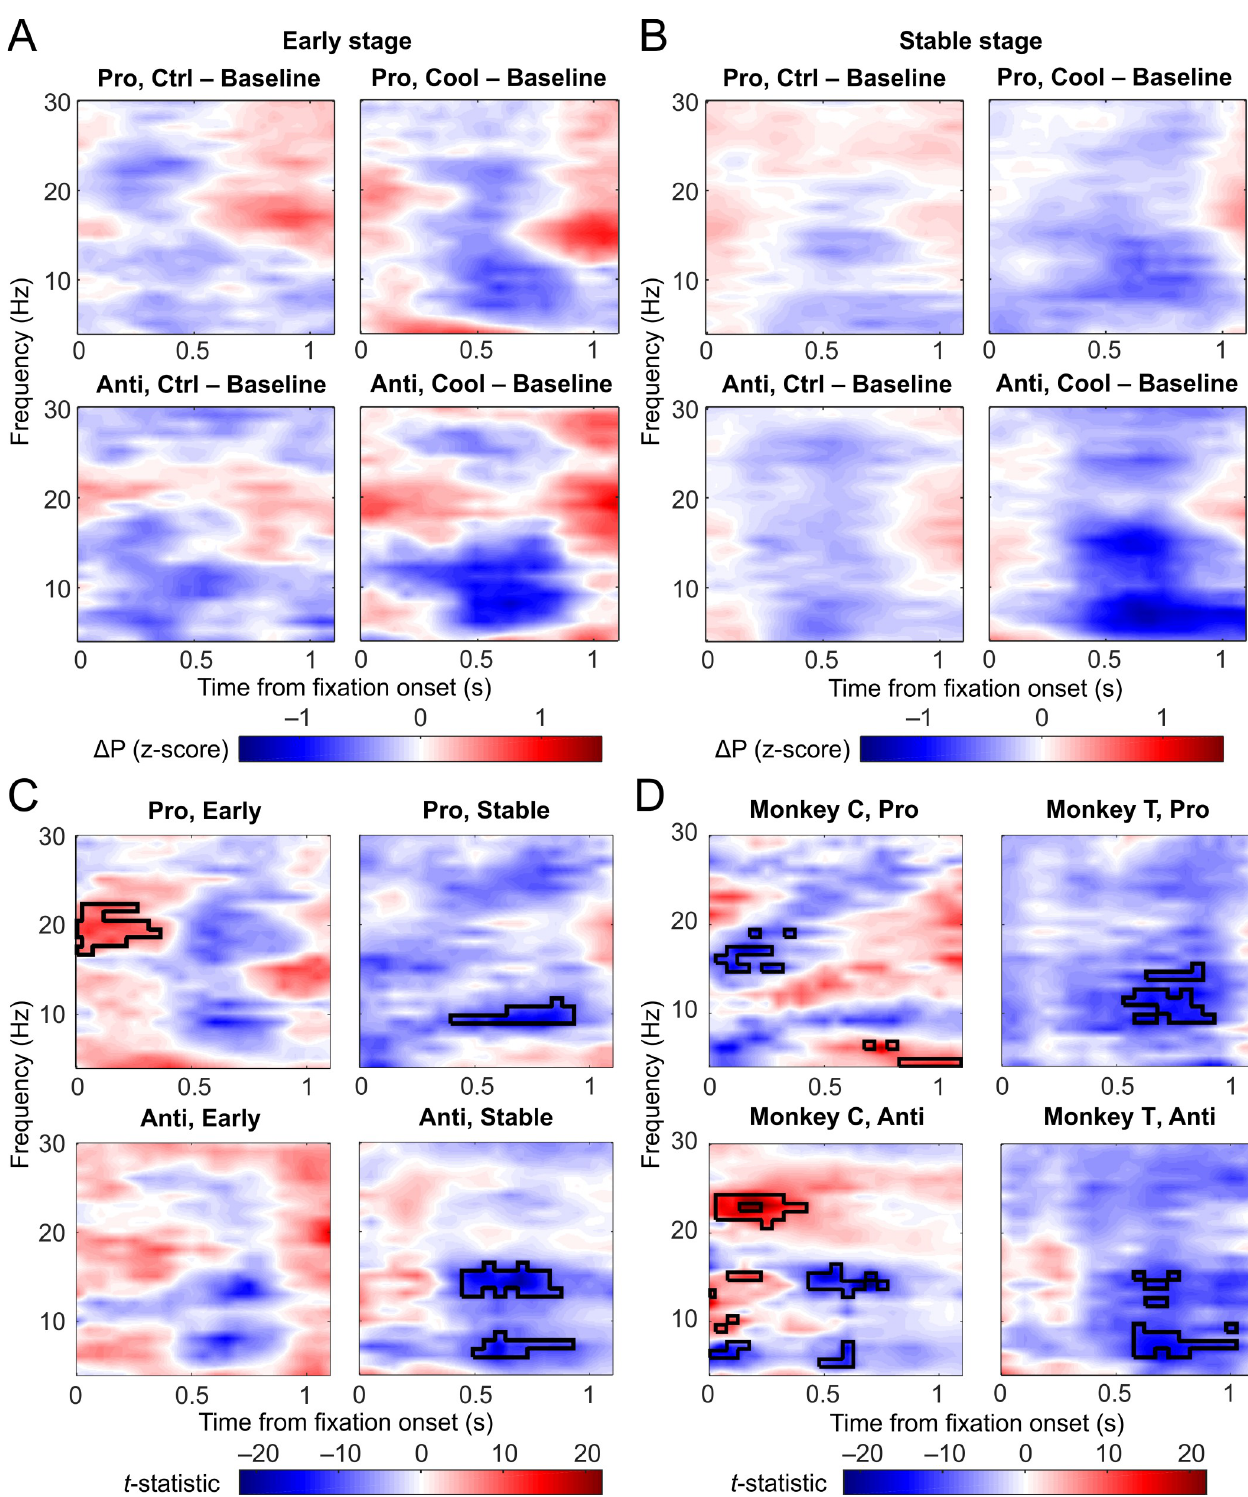
Fig 6. Difference in normalized, time-resolved LFP power between cooling/control epochs and baseline epochs. In (A) and (B), blue color indicates a decrease in LFP power from baseline to cooling/control epochs, and red color indicates an increase in LFP power. (A) Effects of epoch alone in sham sessions (left panels) and of epoch and cooling in cooling sessions (right panels) at the Early stage. Cooling sessions seemed to have a greater decrease in theta and alpha/low beta band compared with sham sessions, as indicated by the darker shade of blue. (B) Effects of epoch alone in sham sessions (left panels) and of